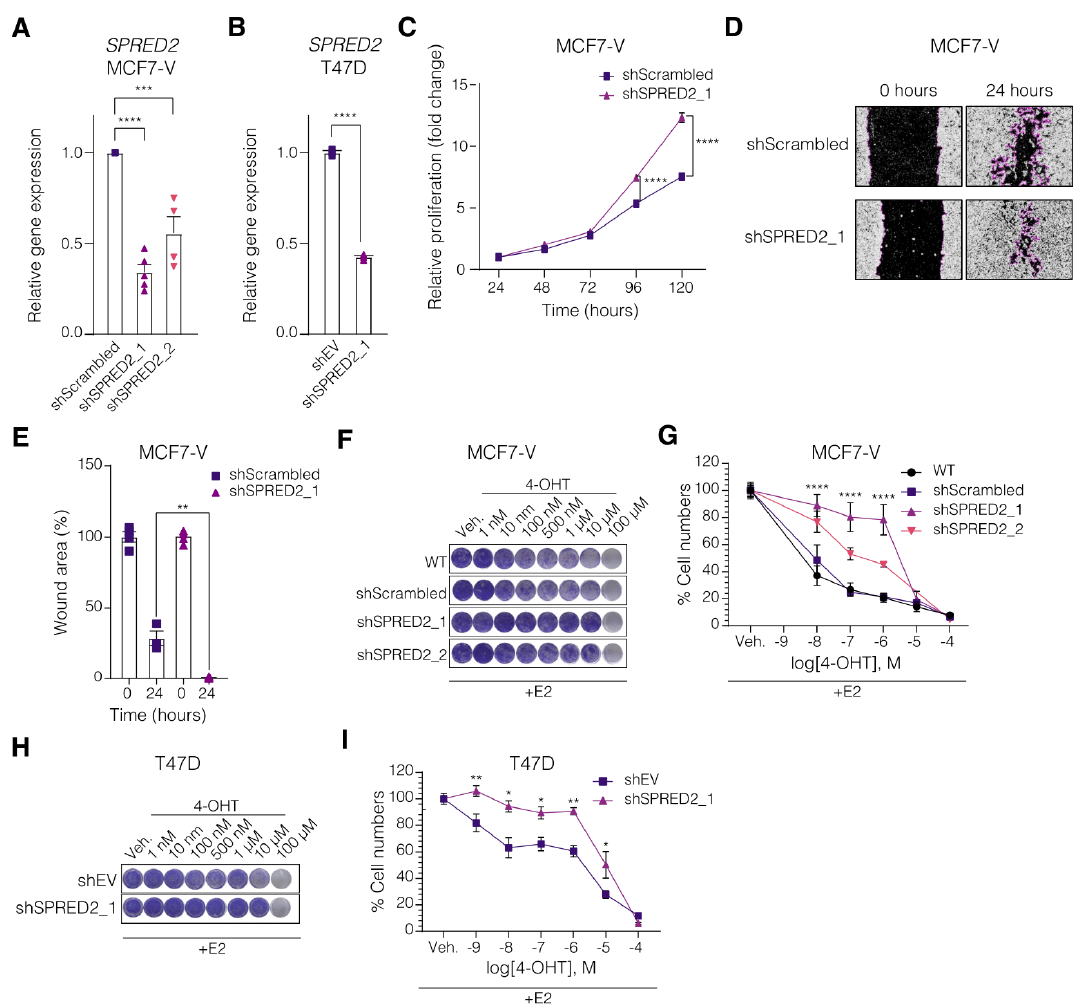
Figure 2. SPRED2 deficiency enhances cell proliferation, migration, and induces resistance to 4-OHT in ERα+ BC cells. ( A , B ) Bar graphs showing the RT-qPCR quantitation of SPRED2 mRNA levels in cells transduced with viral particles for the expression of two different shRNAs targeting SPRED2 or of a negative control shRNA in MCF7-V (shScrambled) ( A ) and of the empty vector in T47D (shEV) ( B ) cells. ( C ) Relative proliferation of MCF7-V cells expressing shScrambled and shSPRED2, measured with a crystal violet assay in monolayer culture. The numbers of cells for each of them are standardized to the corresponding values at 24 h set to 1. ( D ) Cell migration assay with MCF7-V cells with and without SPRED2 knockdown. Representative images of the scratch wound areas, outlined with magenta, at the time of the wounding (0 h) and after 24 h. Images of all four replicates (including these) are presented in Figure S2C,D. ( E ) Bar graphs showing the means of closure for MCF7-V cells. The extent of closure was analyzed with the software ImageJ. ( F ) Cell growth analyzed by crystal violet staining of MCF7-V cells with and without SPRED2 knockdown and treated with increasing doses of 4-OHT. ( G ) Dose–response curves of MCF7-V cells treated with increasing doses of 4-OHT. WT, parent MCF7-V cells. ( H ) Cell growth analyzed by crystal violet staining of T47D cells treated with increasing doses of 4-OHT. ( I ) Dose–response curves of T47D cells treated with increasing doses of 4-OHT; for panels ( F – I ), n = 3 independent experiments in triplicates. All error bars represent the standard errors of the means (mean ± SEM). Asterisks indicate significant differences compared to the samples with shScrambled (MCF7-V) or shEV (T47D) (ns for p > 0.05, * p ≤ 0.05, ** p ≤ 0.01, *** p ≤ 0.001 and **** p ≤ 0.0001). Statistical significance was determined with a one-way ANOVA ( A ), a two-tailed unpaired t -test ( B , E ), and a two-way ANOVA with Bonferroni multiple comparison test for all other